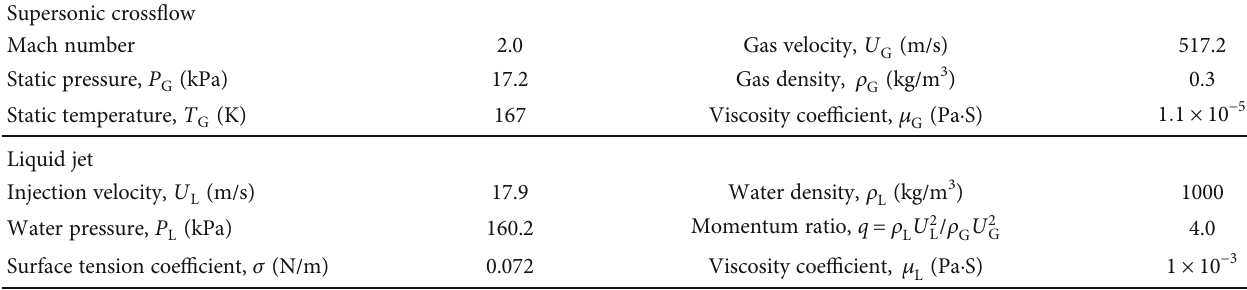
Figure 1: Initialization schematic between the round and elliptical jet. Table 1: Supersonic cross fl ow conditions and liquid jet condition.